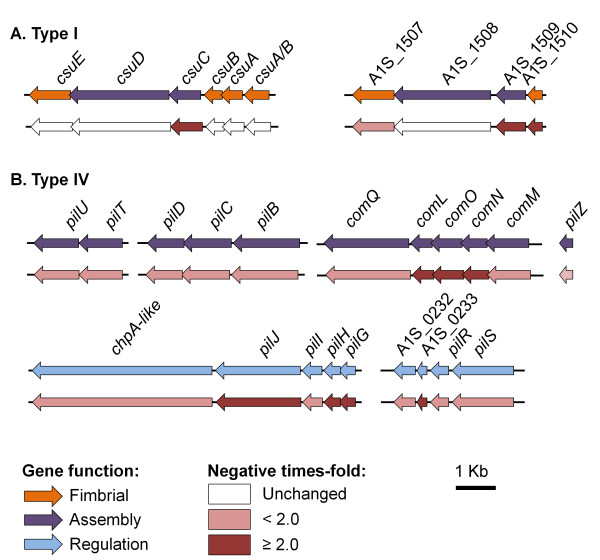
Gene clusters with a putative role in motility. Many genes in the motility COG were found down-regulated including genes of (A) type I and (B) type IV pili. The top set of arrows show predicted gene function; pilus proteins in orange, pilus assembly proteins in purple, and regulatory proteins in light blue. The relative transcriptional differences between A. baumannii grown under iron rich and iron limiting conditions is depicted in the bottom set of arrows, all values are in times-fold. Genes depicted in white were not differentially expressed, those shaded in light red were down-regulated less than 2-fold, whereas those in dark red were down-regulated 2-fold or more. No significant up-regulation was observed within gene clusters related to motility.